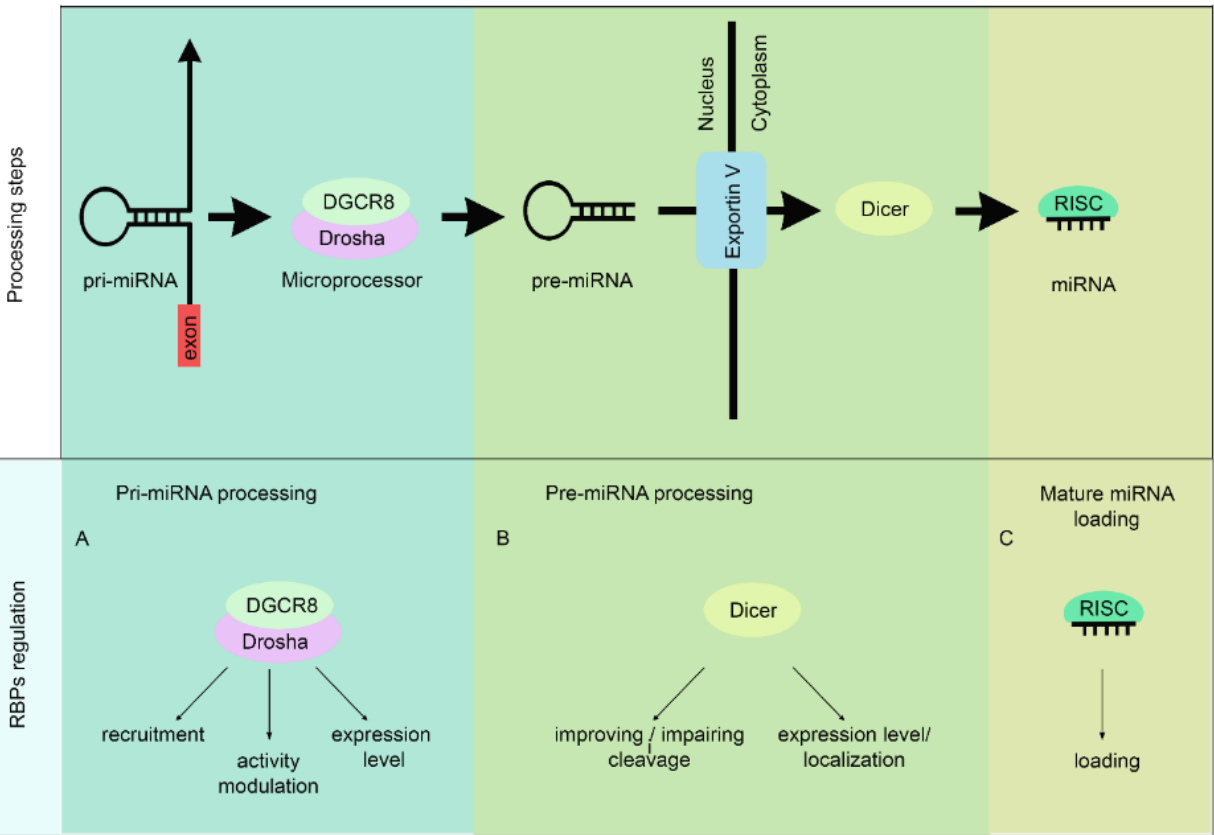
Figure 1. MiRNA biogenesis and RBPs regulation. Upper panel: schematic